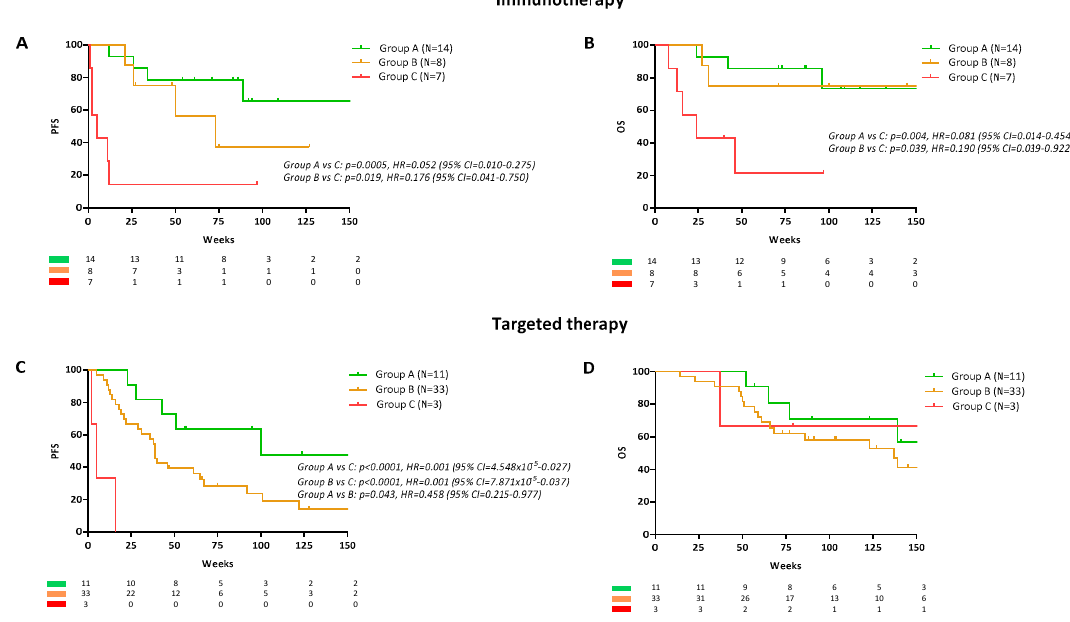
Figure 3. ctDNA levels early during treatment relative to survival. Progression free survival (PFS) and overall survival (OS) curves for patients treated with ( A , B ) immunotherapy or targeted therapy ( C , D ) stratified into the three previously detailed profile groups A, B and C. Cox regression p -values, Hazard Ratio (HR) and 95% confidence intervals (CI) are indicated for each plot.